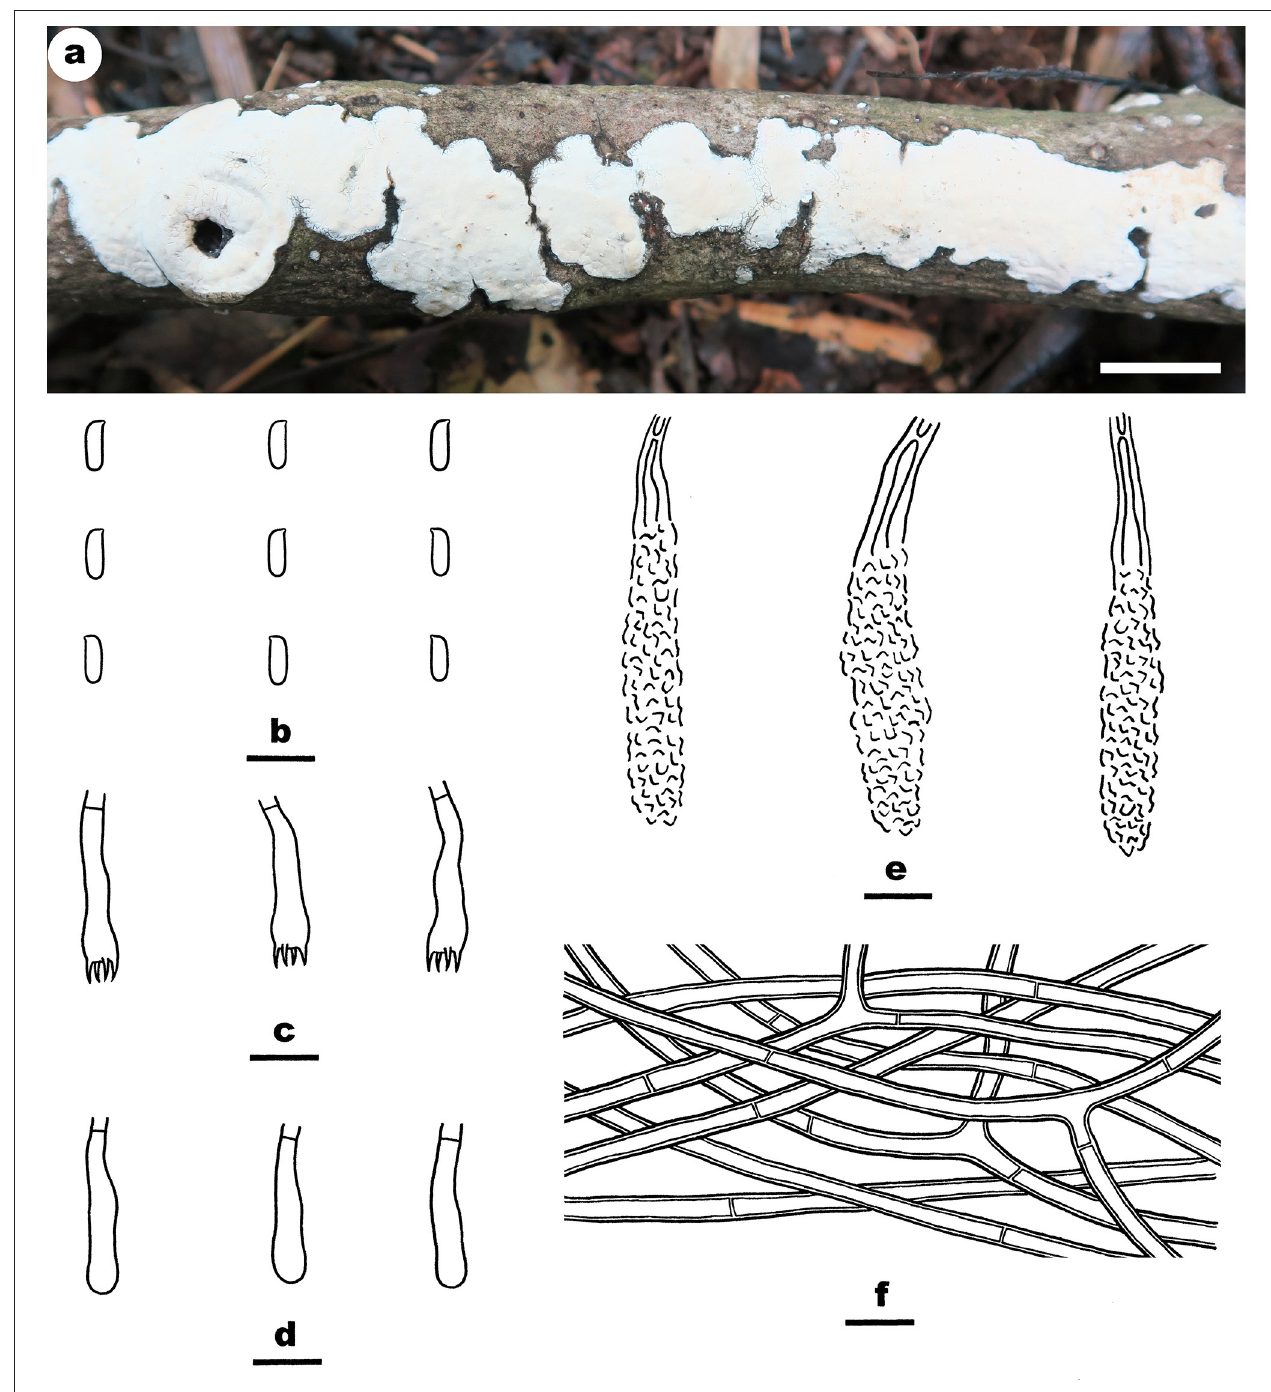
FIGURE 11 | Phanerochaetella sinensis (from the holotype He 4229; scale bars: a = 1cm; b–f = 10 µ m). (A) Basidiomata. (B) Basidiospores. (C) Basidia. (D) Basidioles. (E) Lamprocystidia. (F) Hyphae from subiculum.